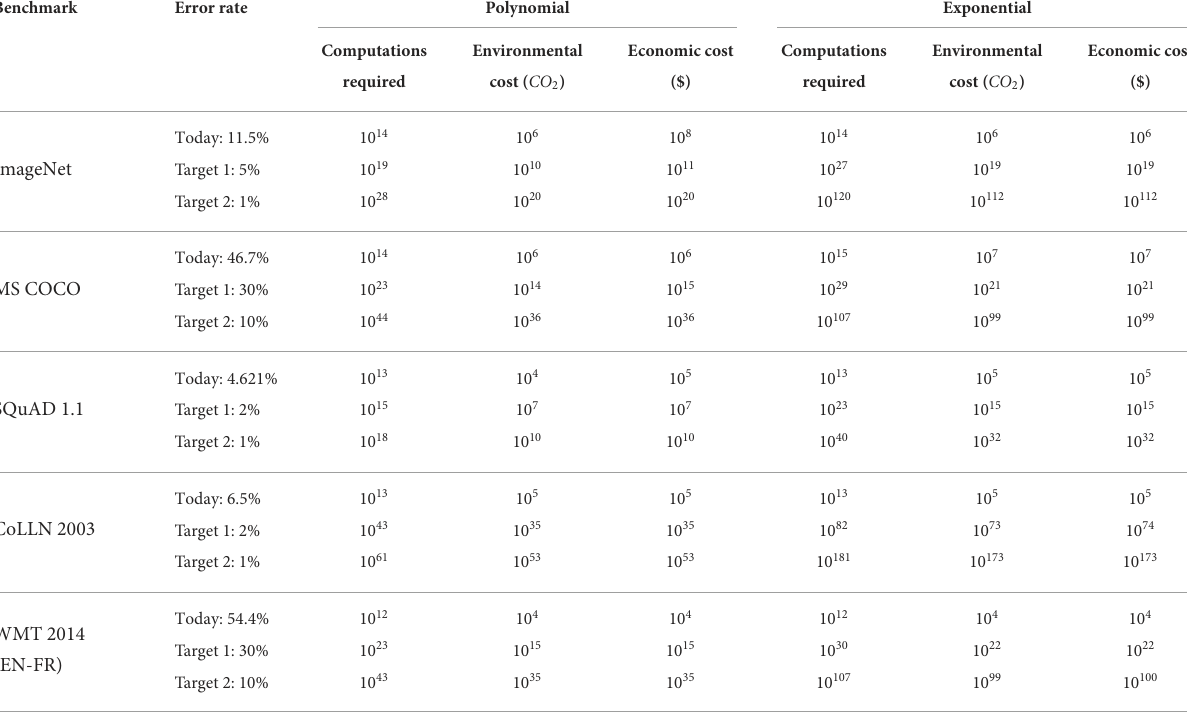
TABLE 2 Computational costs of deep learning.